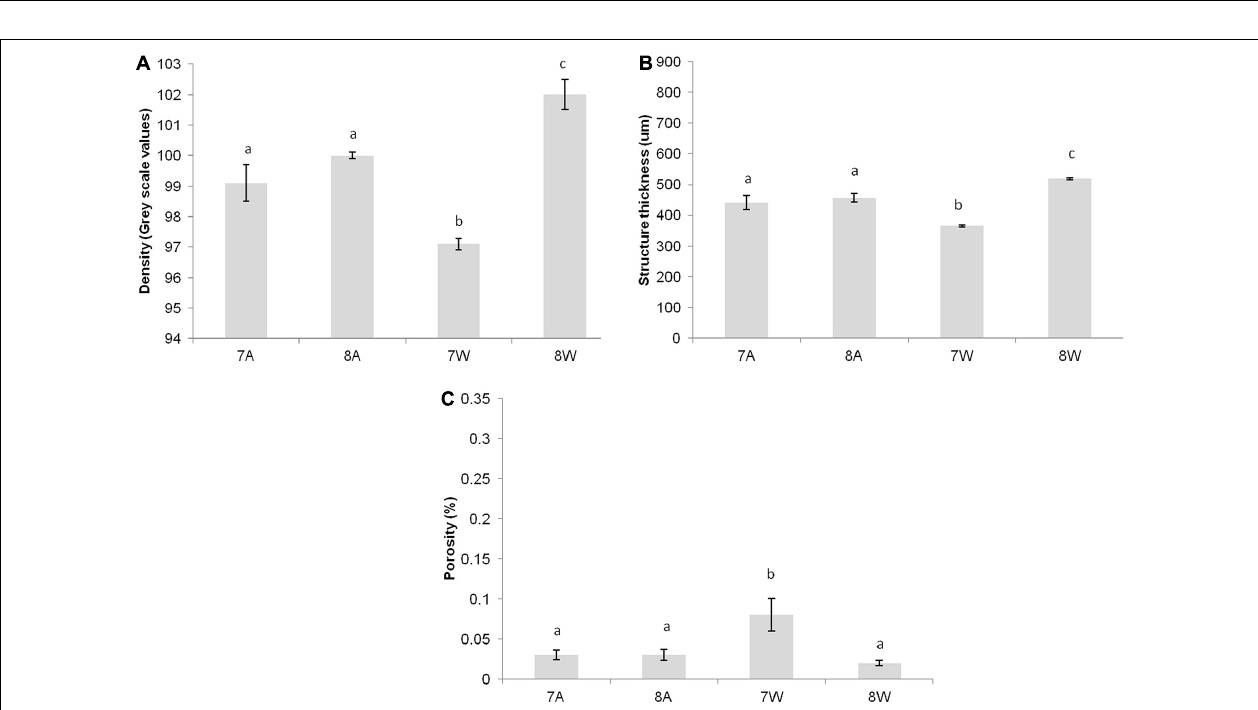
FIGURE 1 | (A) Mean density (grey scale values) of total shell. (B) Mean structure thickness of total shell. (C) Shell closed porosity (%) for Nassarius nitidus . The horizontal axis presents the four different experimental treatments as coded in the text (8A: 20 ◦ C and pH = 8; 7A: 20 ◦ C and pH = 7.7; 8W: 23 ◦ C and pH = 8; 7W: 23 ◦ C and pH = 7.7). Error bars represent ± SE (i.e., variation among individuals). N = 12 N. nitidus per treatment.